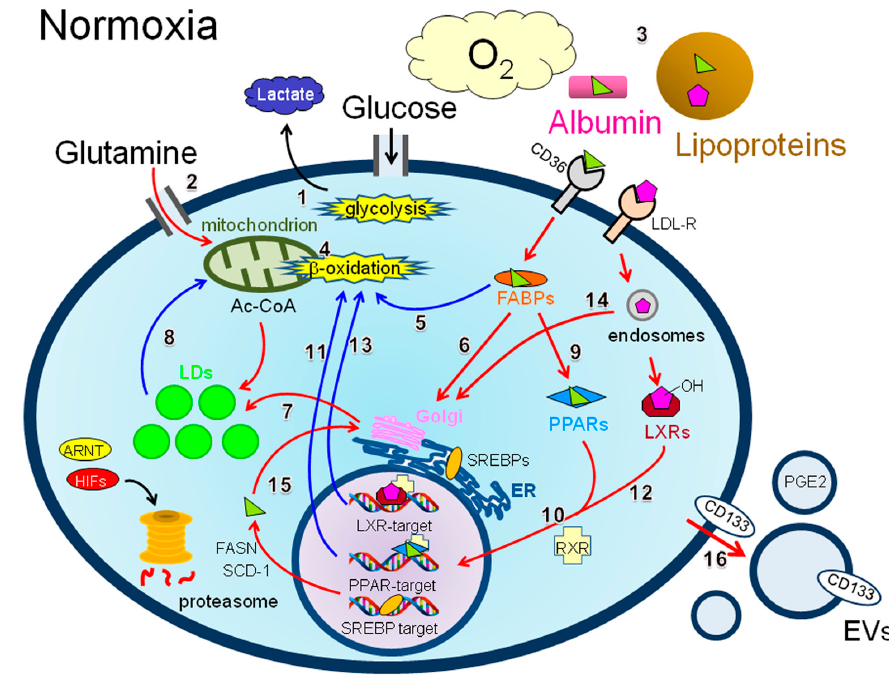
Figure 1. Schematic of the possible metabolic routes associated with lipid droplet (LD) synthesis in cancer cells exposed to normoxic conditions. Under normoxia, cancer cells are expected to have easy access to serum components. Such factors (O 2 , glucose, glutamine, and lipids) are designated by a larger font size compared with that of lactate. Major metabolic energy sources (glycolysis and β -oxidation) are depicted with star bursts. Metabolic routes (1–16) possibly associated with LD synthesis and β -oxidation are designated with red and blue arrows, respectively. Other routes are shown in black arrows. The abbreviations used are as follows: LDs = lipid droplets; ER = endoplasmic reticulum; HIFs = hypoxia inducible factors; ARNT = arylhydrocarbon receptor nuclear translocator; Ac-CoA = acetyl coenzyme A; LCFAs = long chain fatty acids; FABPs = fatty acid binding proteins; PPARs = peroxisome proliferator-activated receptors; LXRs = liver X receptors; SREBPs = sterol regulatory element binding proteins; RXR = retinoid X receptor; FASN = fatty acid synthase; SCD-1 = stearoyl CoA desaturase-1; LDL-R = low-density lipoprotein receptor; EVs = extracellular vesicles. The symbols used are as follows: : LCFAs, : cholesterol, : transporter, : receptor.